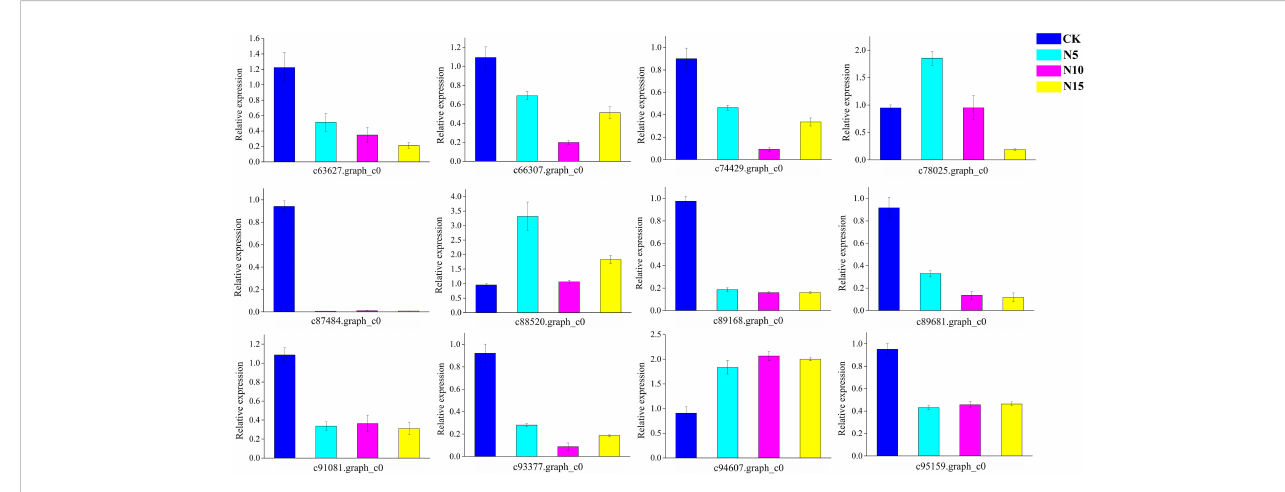
FIGURE 9 The qRT-PCR analyses of randomly selected genes in CK, N5, N10, and N15 group